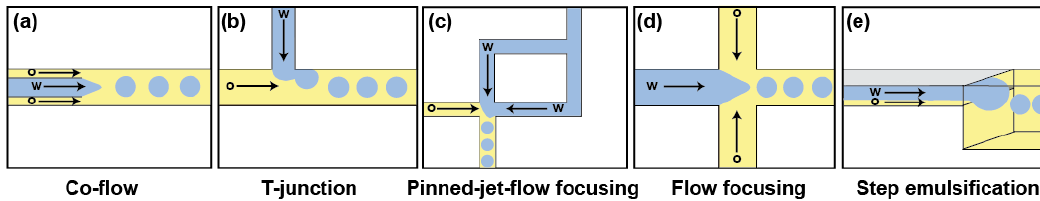
Figure 2. Main geometries used for droplet generation. ( a ) Droplet generation by co-flowing an aqueous phase (in blue) arriving from a capillary immersed in an oil stream (yellow). ( b – d ) Droplet generators with planar geometries. Channels in which oil (shaded in yellow) and aqueous phase (shaded in blue) flow are respectively labeled “o” and “w”. Arrows indicate flow directions. ( e ) Schematic of a step emulsification process.